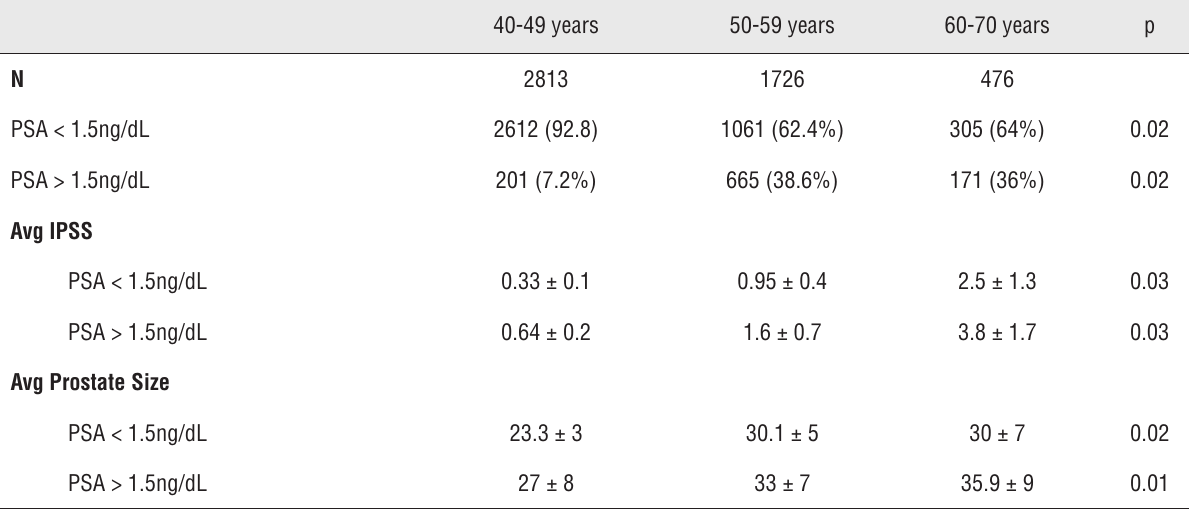
Table 4 - The prevalence of PSA greater or less than 1.5ng/dL and its correlation with IPSS and prostate size.